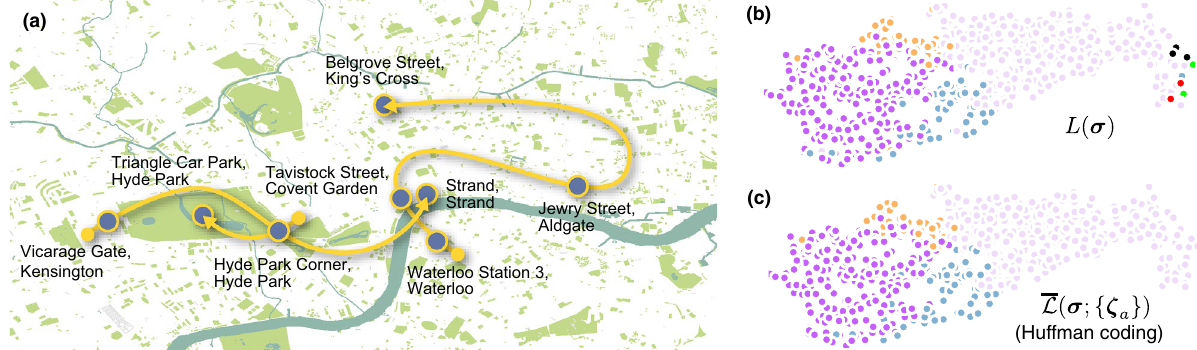
Figure 7. Community detection of the bike-sharing dataset. ( a ) Three trajectories in the dataset, where each point (node) represents the location of a bike station. The partitions of the stations are obtained by minimising ( b ) L ( σ ) (detected 8 modules) and ( c ) L ( σ ; { ζ a } ) based on the Huffman coding (detected 4 modules). The stations in the same module are indicated in the same